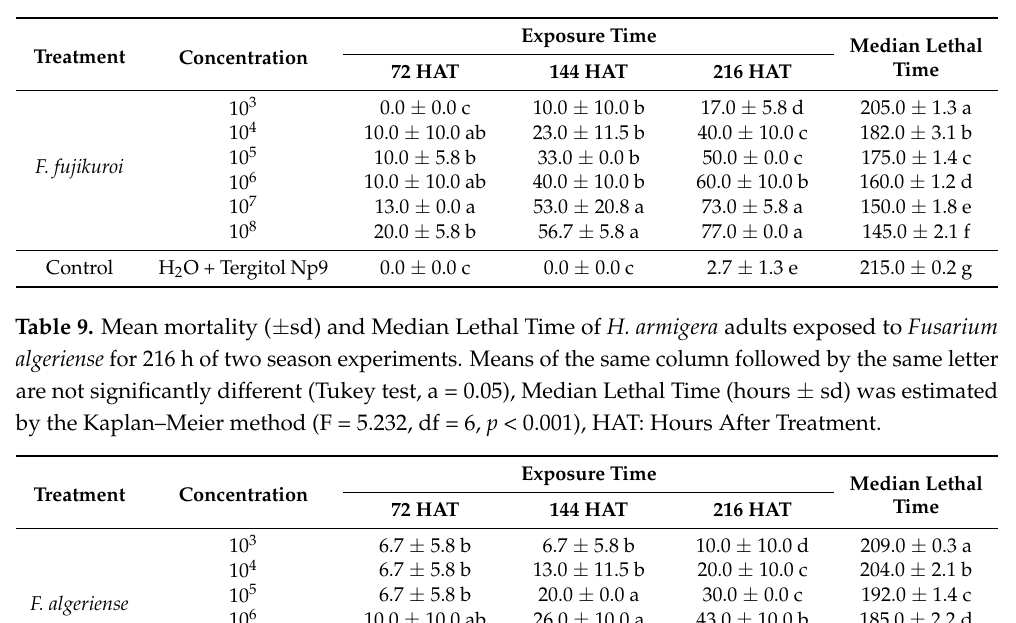
Table 8. Mean mortality ( ± sd) and Median Lethal Time of H. armigera adults exposed to F. fujikuroi for 216 h of two season experiments. Means of the same column followed by the same letter are not significantly different (Tukey test, a = 0.05), Median Lethal Time (hours ± sd) was estimated by the Kaplan–Meier method (F = 5.330, df = 6, p < 0.001), HAT: Hours After Treatment.